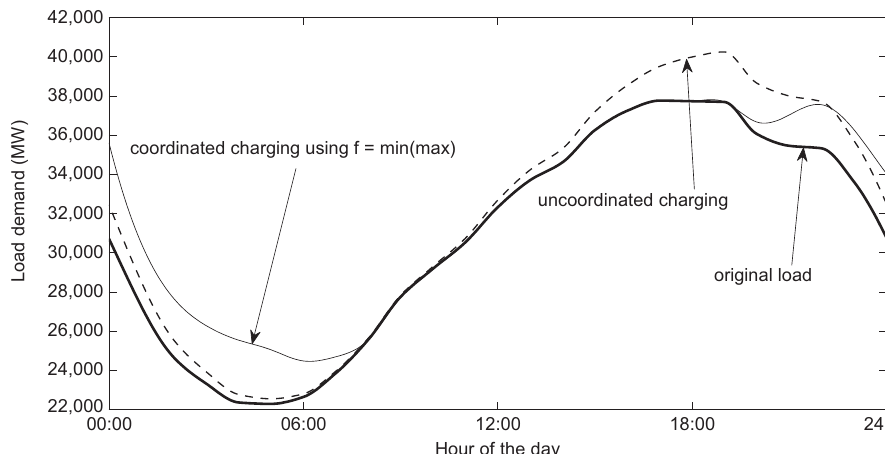
Figure 10. Optimized load